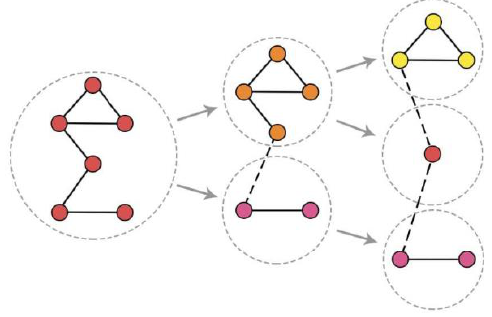
Figure 1. Community evolution process of top-down division.